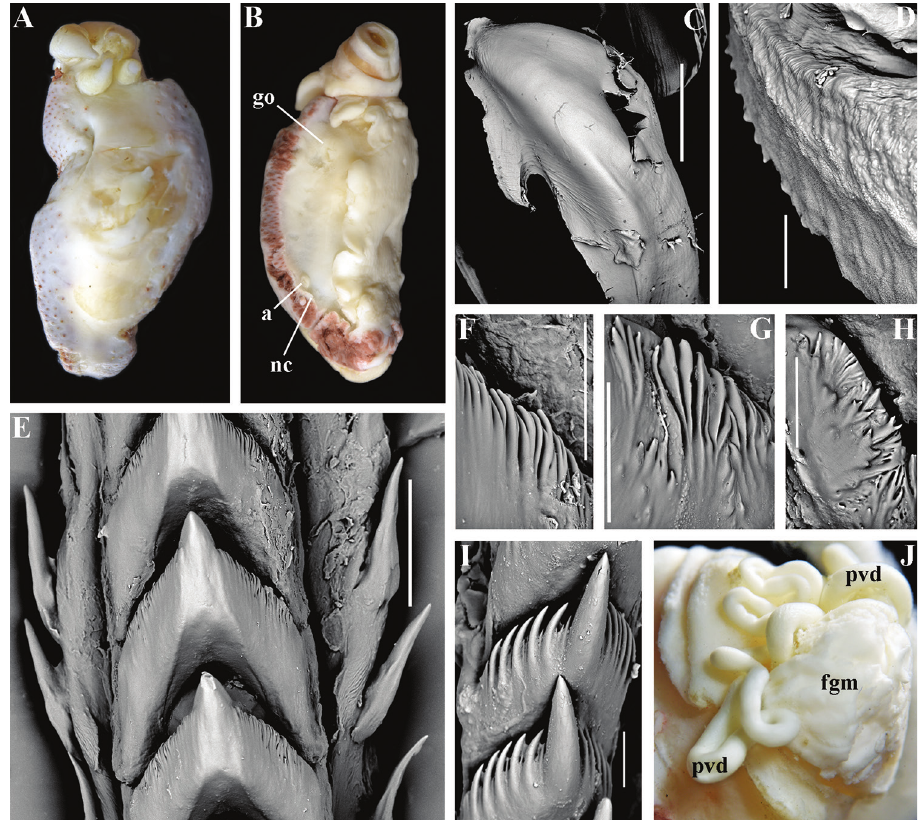
Figure 12. Ziminella abyssa sp. n.: A preserved holotype (Sea of Japan, ZSM Mol-20100647, 2676 m), dorsal view, 19 mm in fixed length B same, latero-ventral view C jaw, SEM ZMMU Op-259, depth 3460 m D details of masticatory process of jaws E radular teeth, posterior part, SEM ZMMU Op-250, 24 mm length, 3300 m F–H details of three central teeth with additional or highly aberrant lateral denticles ZMMU Op-248, 12 mm length, 3560 m I rachidian tooth of juvenile specimen 2 mm length showing additional lateral denticles ZMMU Op-264, 1525 m J reproductive system, light microscopy ZSM Mol- 20100644, 3213 m. Abbreviations: a anus fgm female gland mass go genital opening nc continuous notal edge pvd prostatic vas deferens. Scale bars: C = 1 mm; E = 50 μm; F, G, H = 300 μm. Photos and SEM images by A.V.